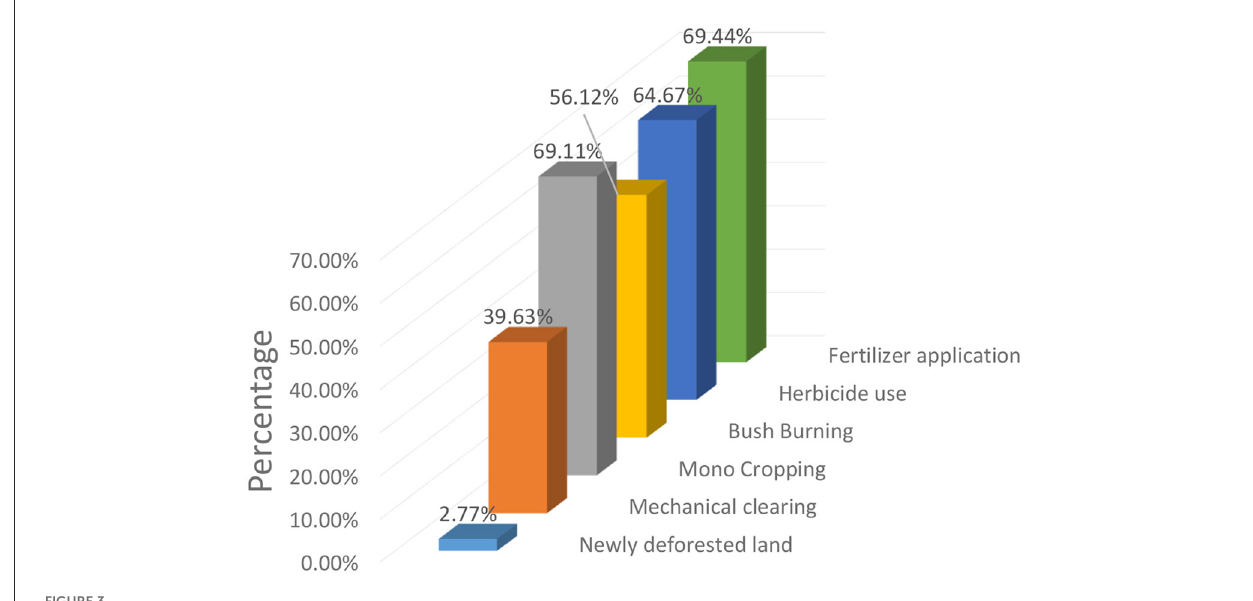
FIGURE3 Land-use antecedents among the smallholder farmers.